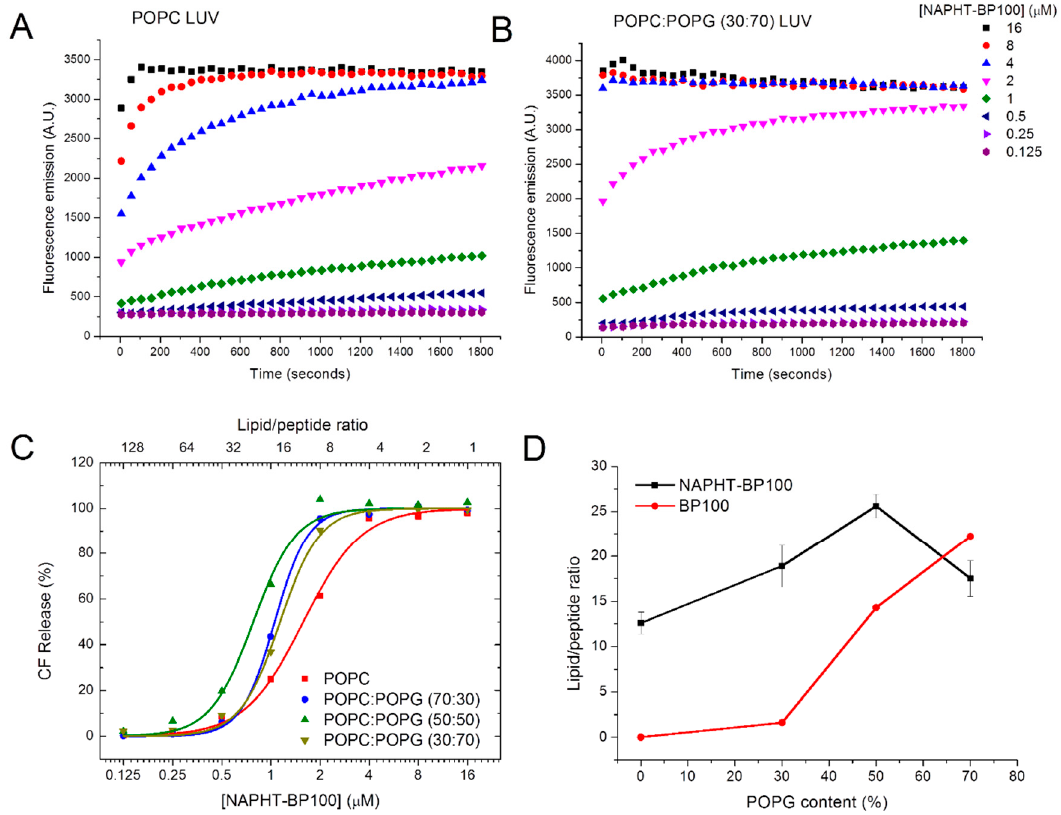
Figure 6. CF ‐ induced leakage by NAPHT ‐ BP100. Lipid concentration was 20 μ M in Tris ‐ HCl 10 mM, pH 7.4, with 300 mM NaCl. ( A ) POPC LUV and ( B ) POPC:POPG (30:70) LUV. ( C ) Percentage of CF release from LUV of varied lipid composition as a function of Napht ‐ BP100, after 30 min. ( D ) The lipid/peptide ratio required to permeabilize 50% of LUV as a function of POPG content. Measurements performed at 37 °C.